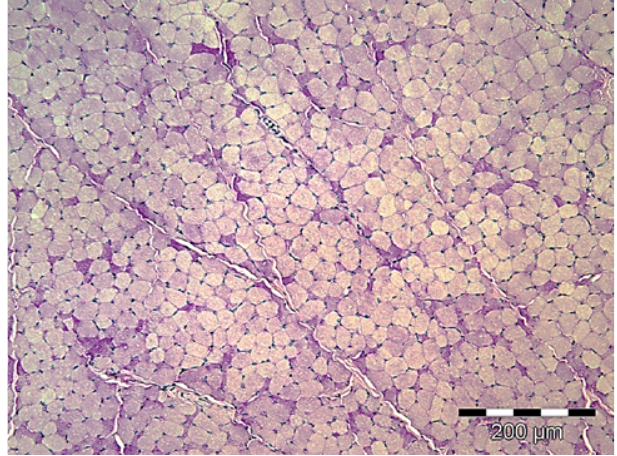
Figure 6c: The m. tibialis cranialis muscle in transverse section stained with PAS showing fibre size and staining variation; fibres in general less atrophied than in m. biceps brachii (Figs 3a, 3b & 6b). PAS, light microscopy, magnification